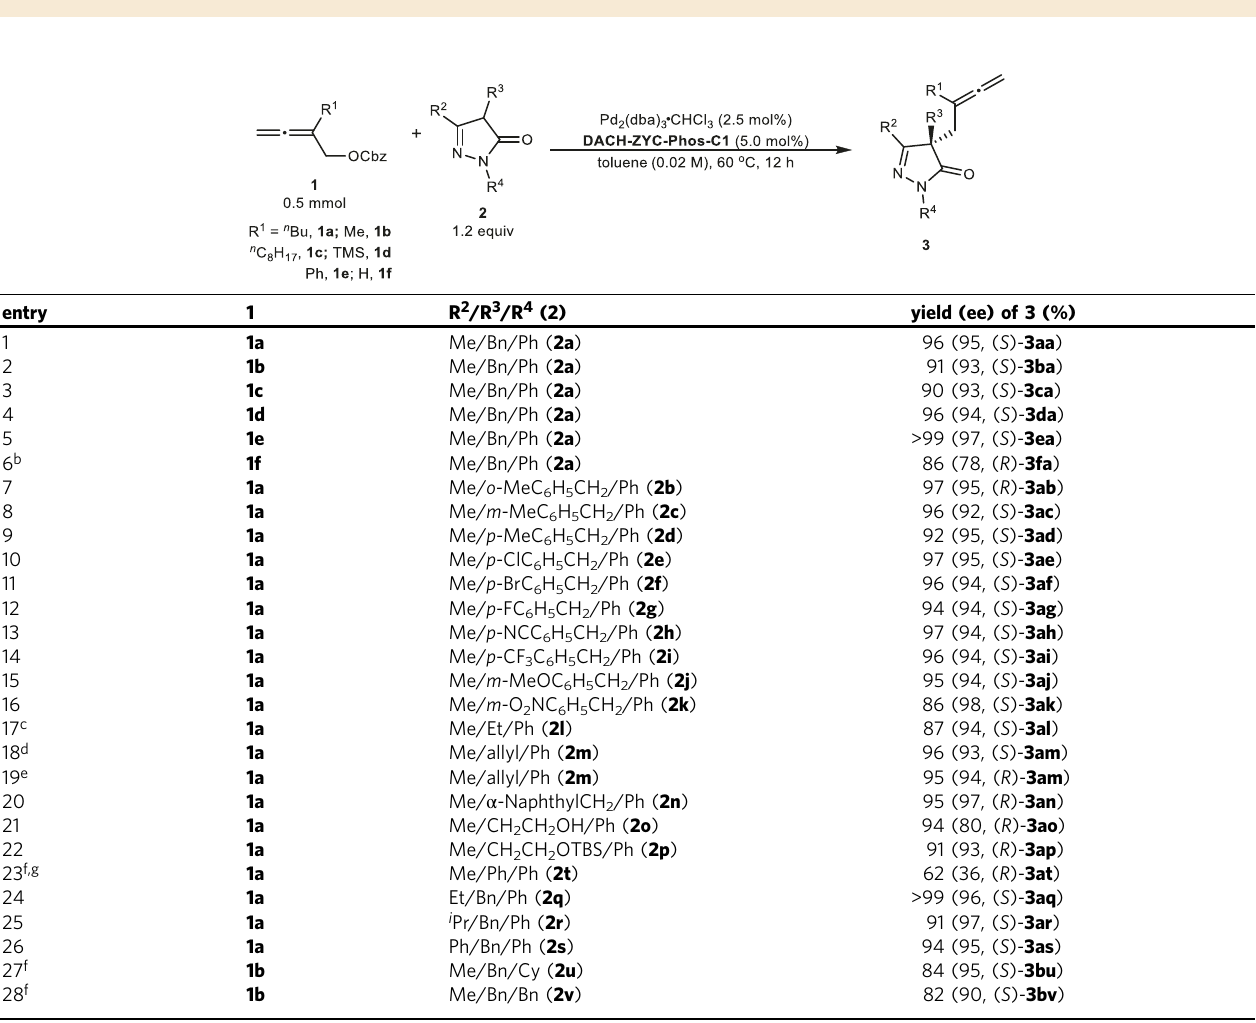
Table 2 The scope of allenes and pyrazol-5-ones a